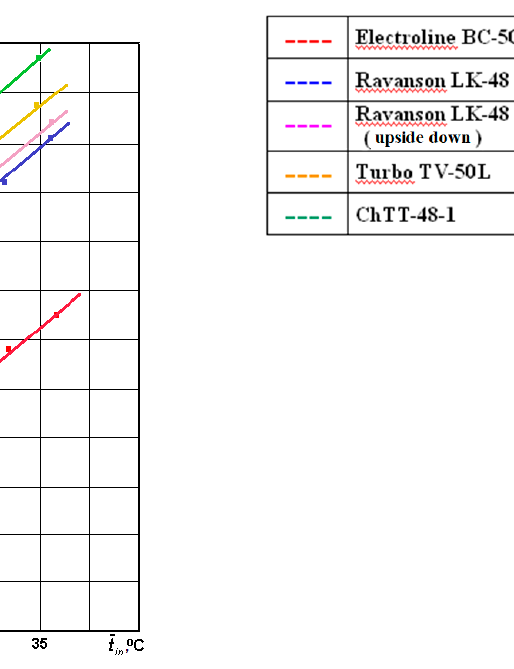
Figure 6. The values of the overall thermal transfer coefficient k of four refrigerators, calculated on the basis of the experiment data depending on the average insulation temperature t in .